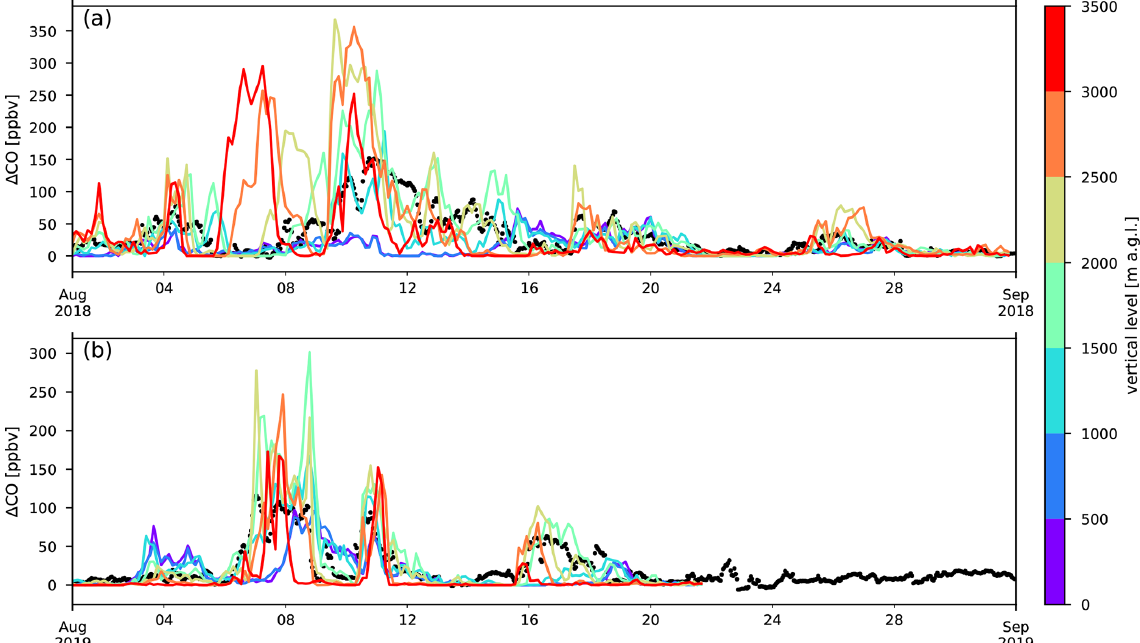
Figure 4. Comparison between measured excess CO (black) at RUN to that modelled on different vertical levels of the FLEXPART model during August 2018 (a) and August 2019 (b) . FLEXPART output levels are defined in metres above ground level